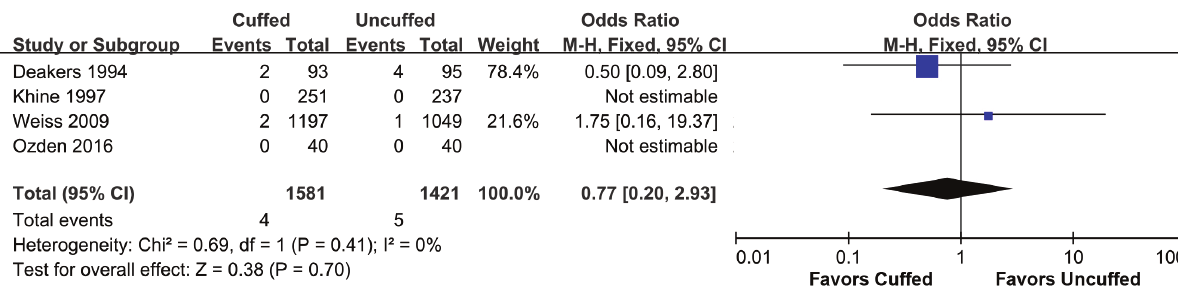
Supplemental Figure 2: The meta-analysis of accidental extubation between cuffed and uncuffed groups.